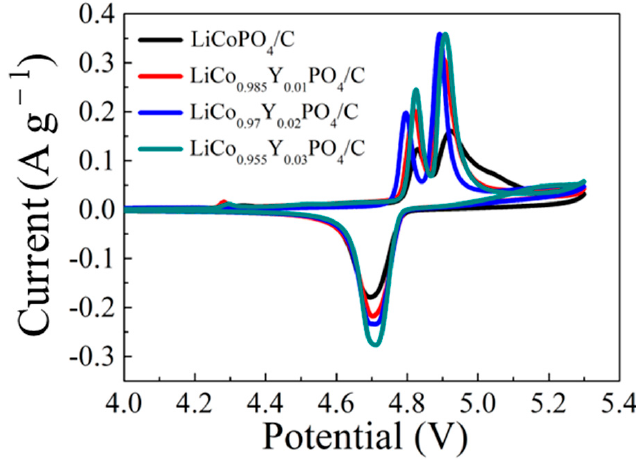
Figure 7. CV curves of the four electrodes. Table 2. The differences of the CV curves of the four electrodes. Table 2. The differences of the CV curves of the four electrodes.